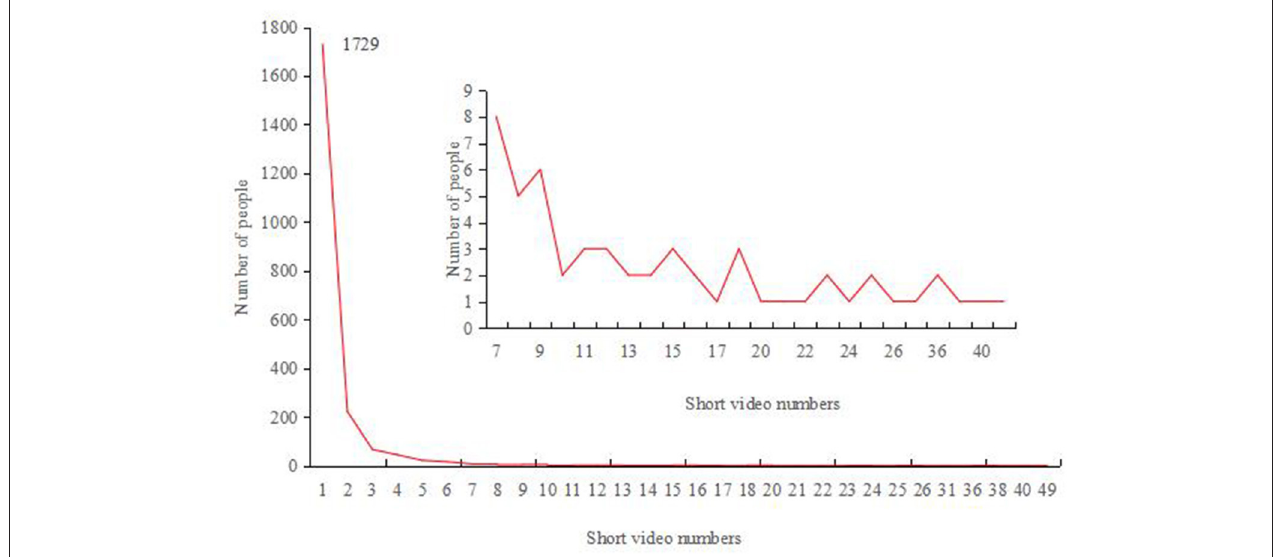
FIGURE 3 | Quantity characteristics of short videos released by individual disseminators during COVID-19 epidemic period.